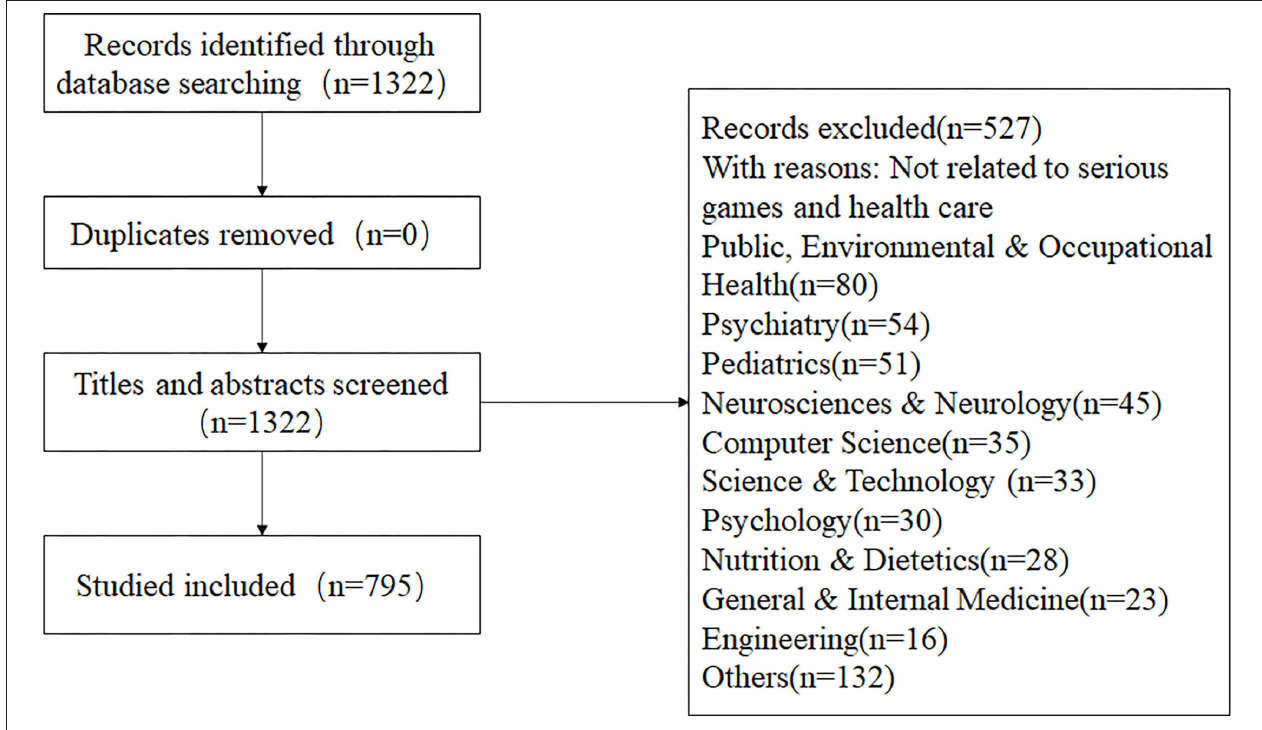
FIGURE 1 | Flow diagram of study